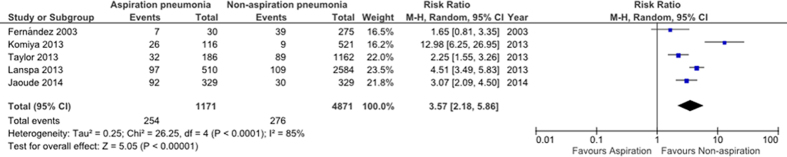
Pooled mean difference for 30-day mortality with 95% confidence intervals for eligible studies.